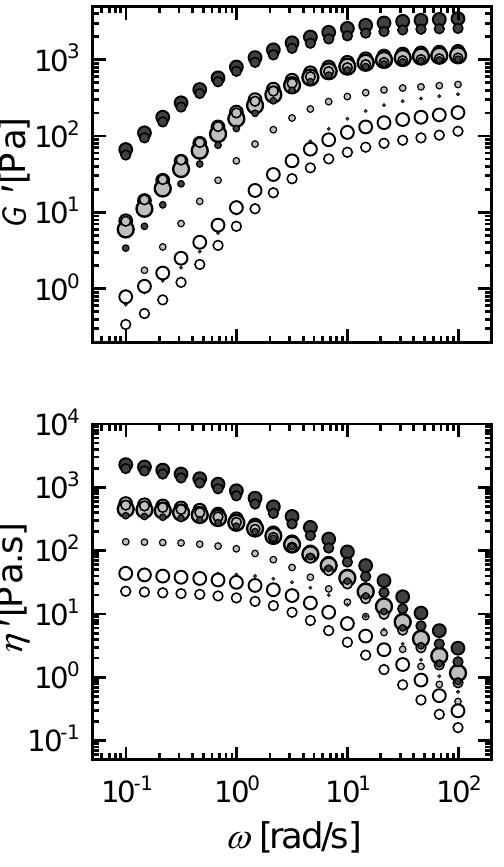
Figure 10: Linear viscoelastic moduli ( G ′ , η ′ ) for a selection of con- centrations of PVA-Borax systems show Maxwell-like behavior of the system. Concentration of PVA (2, 2.75, 3 wt%) is indicated by color intensity (low to high). Concentration of Borax (0.05, 0.1, 0.5, 1.25, 1.5) is indicated by symbol size. Data collected by Olivia Carey-De La